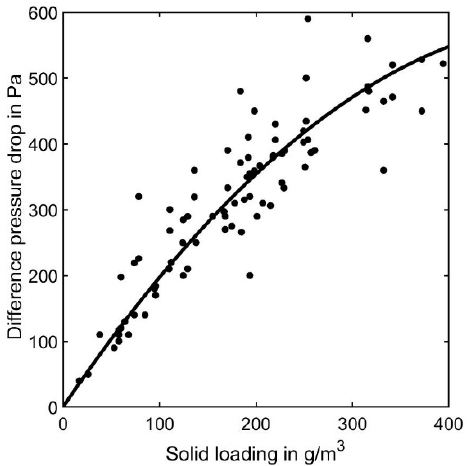
Figure 5. The pressure loss difference between unloaded and loaded flow as a function of solid loading under different operating conditions.